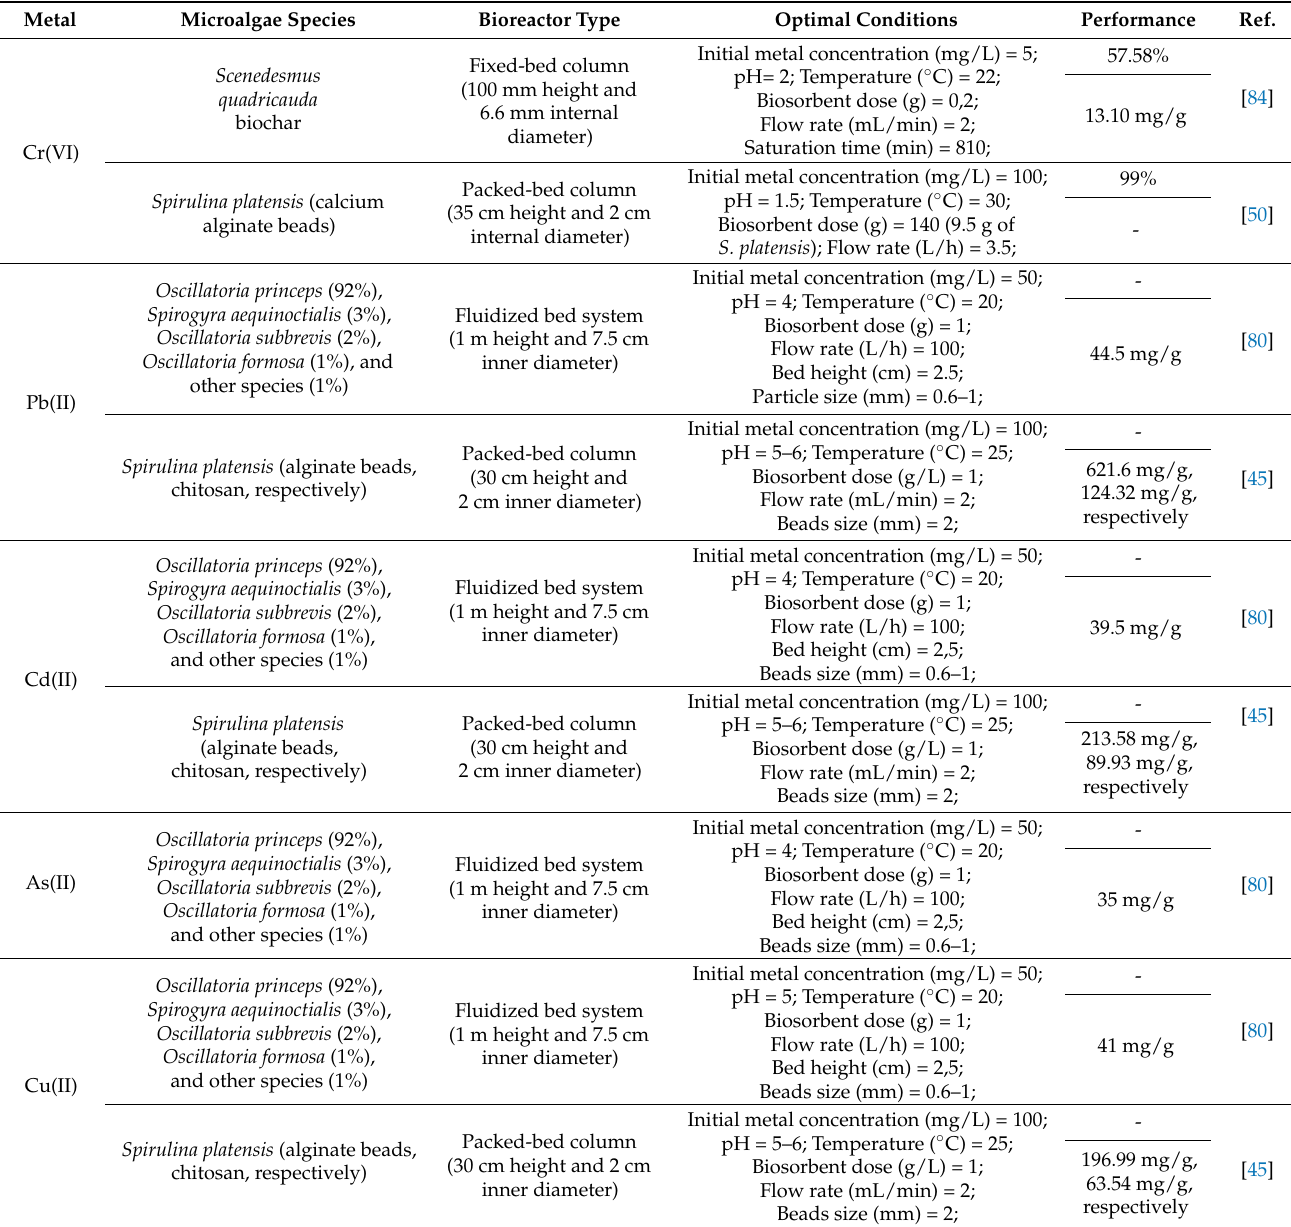
Table 2. Removal of heavy metals in a continuous system using microalgal